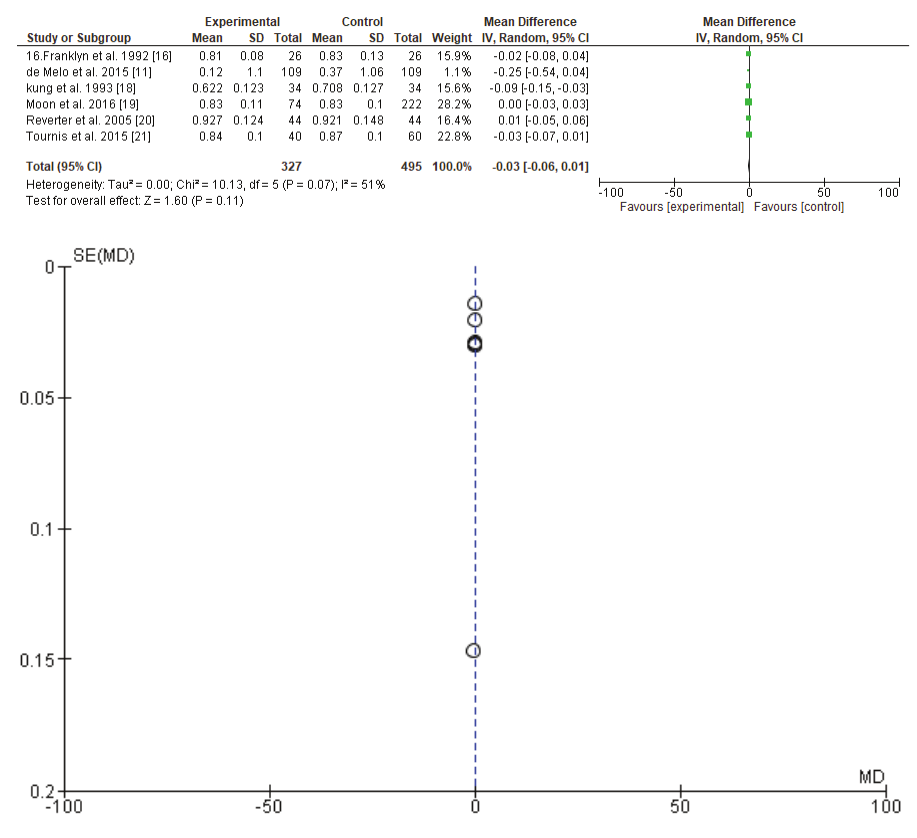
Figure 5 : TSH suppression and bone mineral density among postmenopausal women femoral